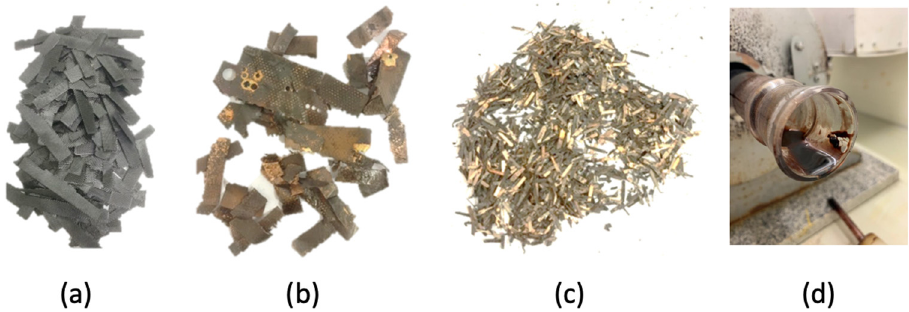
Figure 11. Macroscopic aspects of some relevant materials recovered in the process: ( a ) fiberglass; ( b ) copper sheets; ( c ) magnetic contacts; ( d ) condensed liquid.